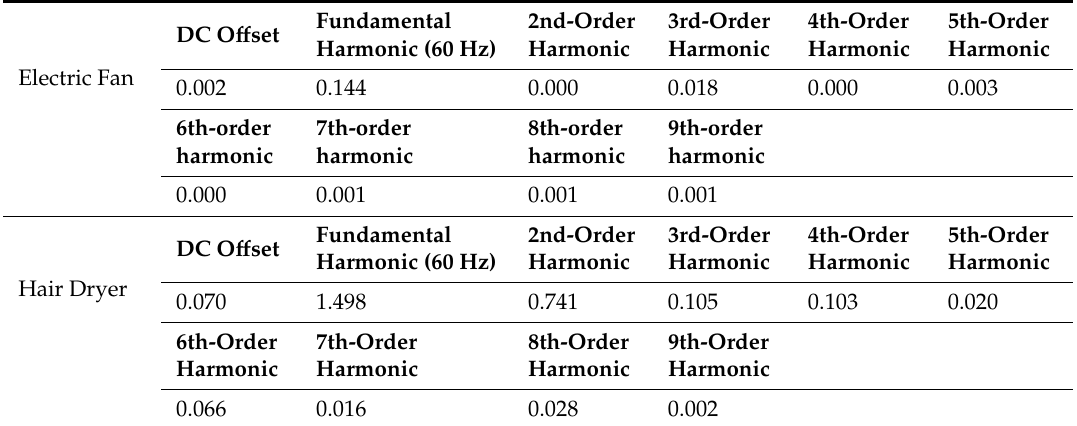
Table 2. Resulting current harmonics produced by two types of electrical appliances and obtained through fast Fourier transform (FFT) in this